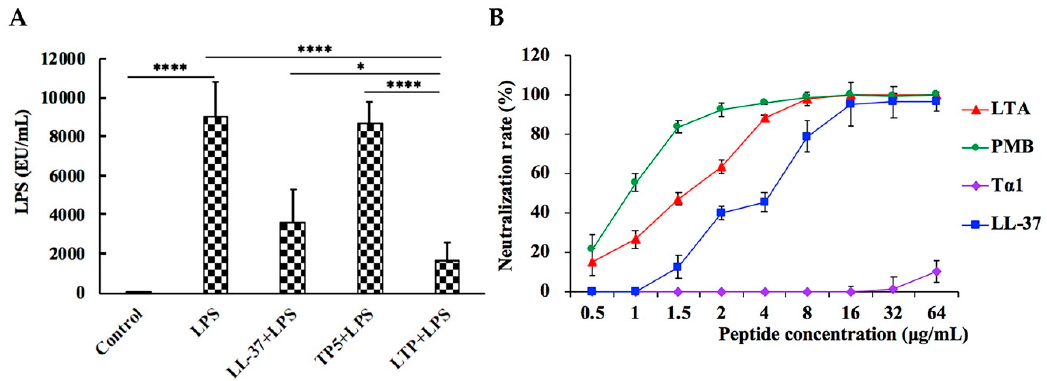
Figure 9. LPS neutralization activity of LTP in vitro and in vivo. ( A ) The LPS concentration in mouse plasma. ( B ) In-vitro LPS neutralization by LTP. LPS neutralization activity of LTP, LL-37, TP5, and PMB were determined using the chromogenic in vitro TAL assay. Data are presented as the mean value ± standard error from three biological replicates. *: p ≤ 0.05, ****: p ≤ 0.0001.